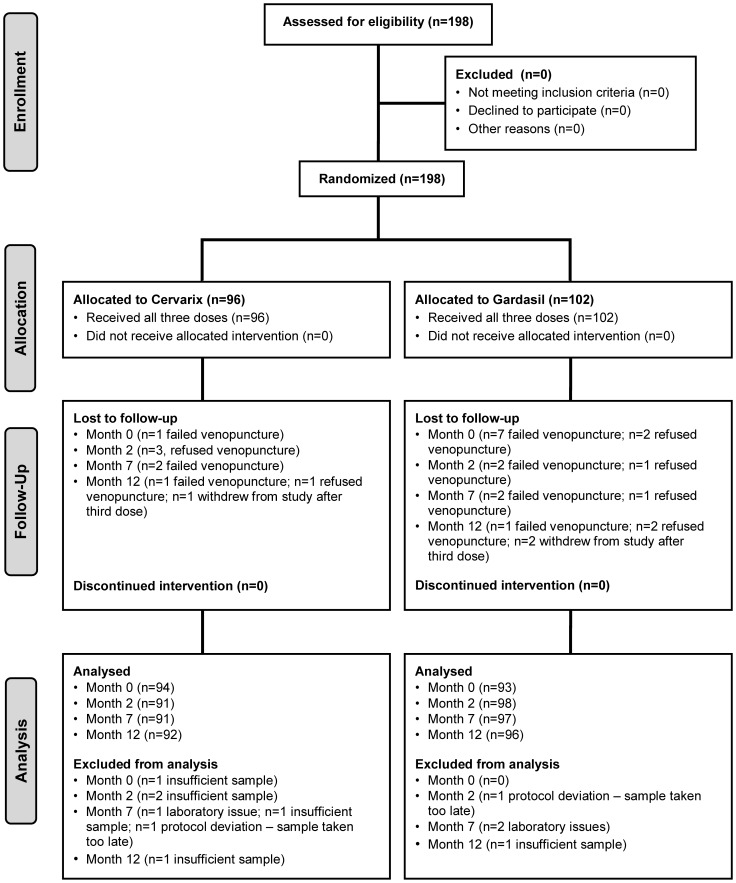
CONSORT diagram.Allocations, interventions, follow up and analysis of 198 subjects recruited into the comparative HPV vaccine immunogenicity study.